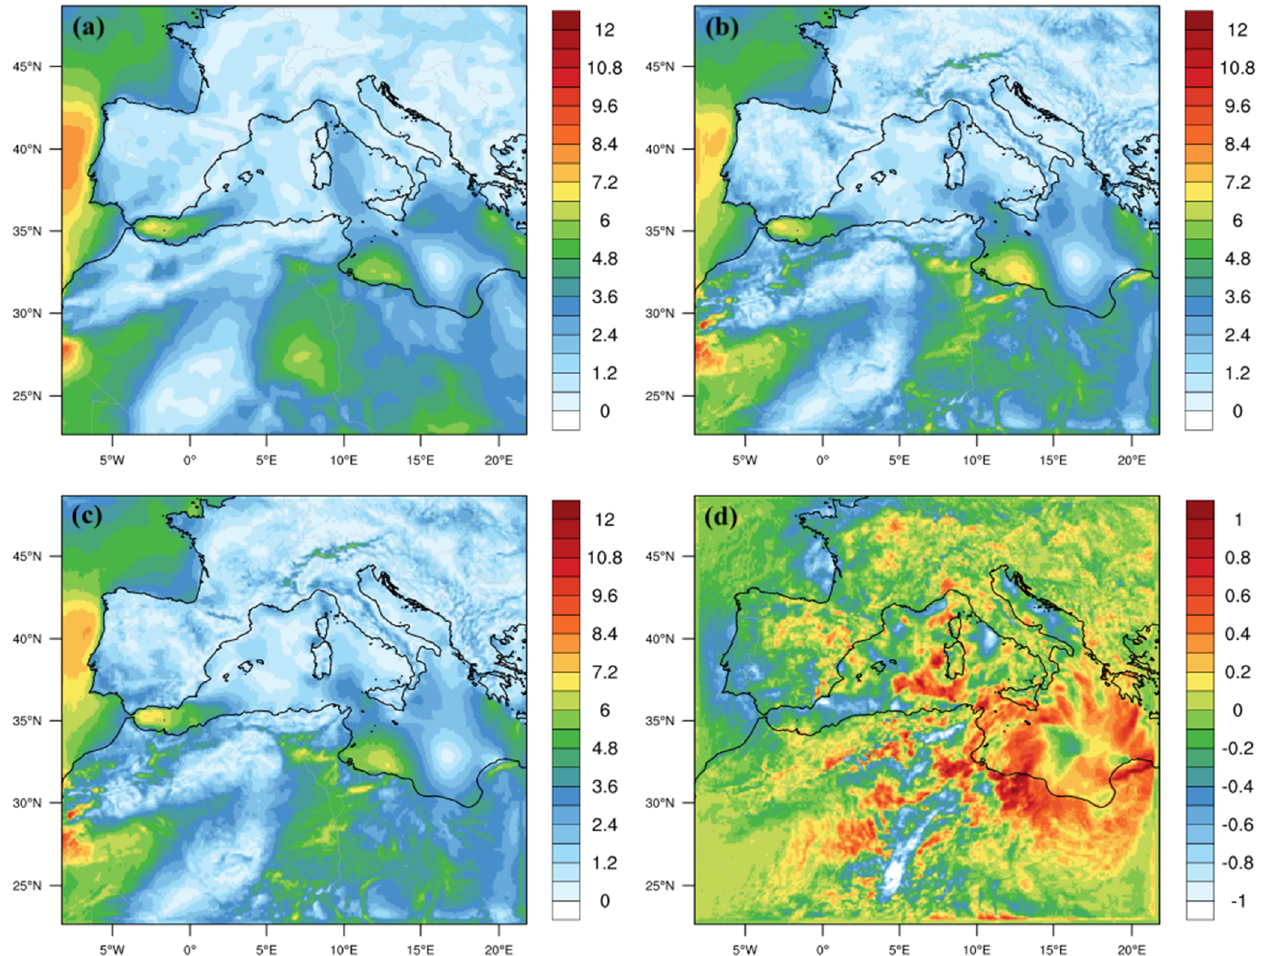
Figure 6. Period averaged (17–24 June) wind speed at 10 m (ws 10 ) in m s − 1 for: ( a ) ERA5 reanalysis; ( b ) CTL run; ( c ) FULL run and ( d ) ws 10 difference between CTL and FULL.